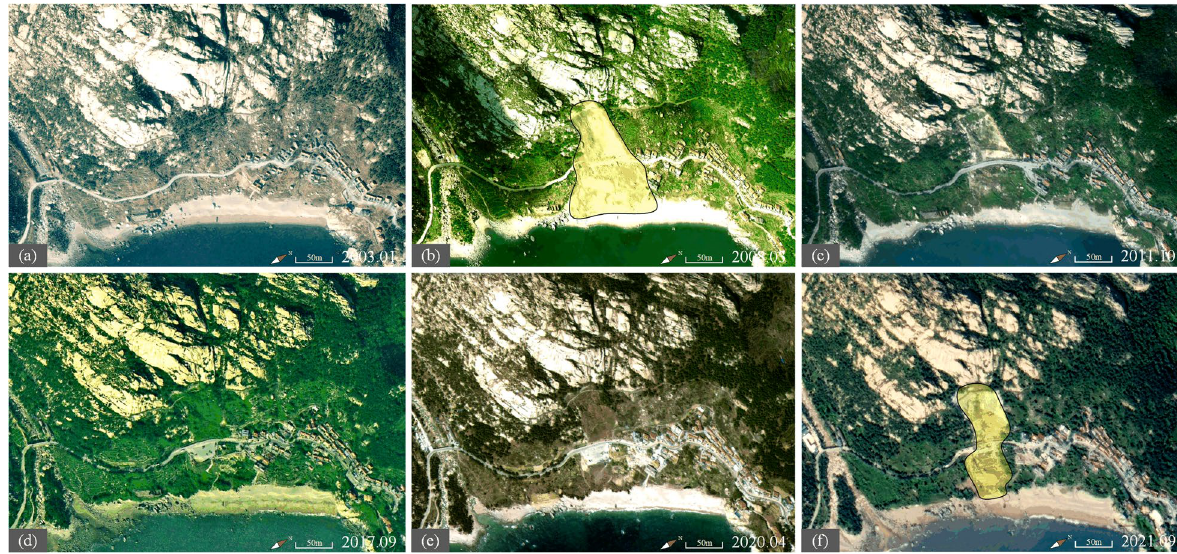
Fig. 4 Historical image map of landslide. b The shape of the first landslide occurred in August 2007 f The shape of the second landslide occurred in July 2020 (shot in September 2021). Others ( a , c , d , e ) are the historical image map of landslide in 2003, 2011, 2017 and April